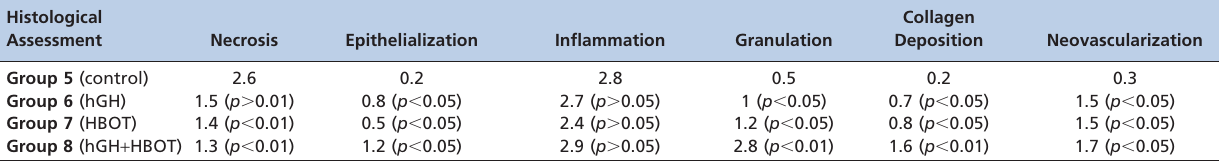
Table 4 - Histological assessment in the non-ischemic groups (all parameters scored from 0 to 3). The p -value compares group 1 to the other groups. All of the values are expressed as the means ¡